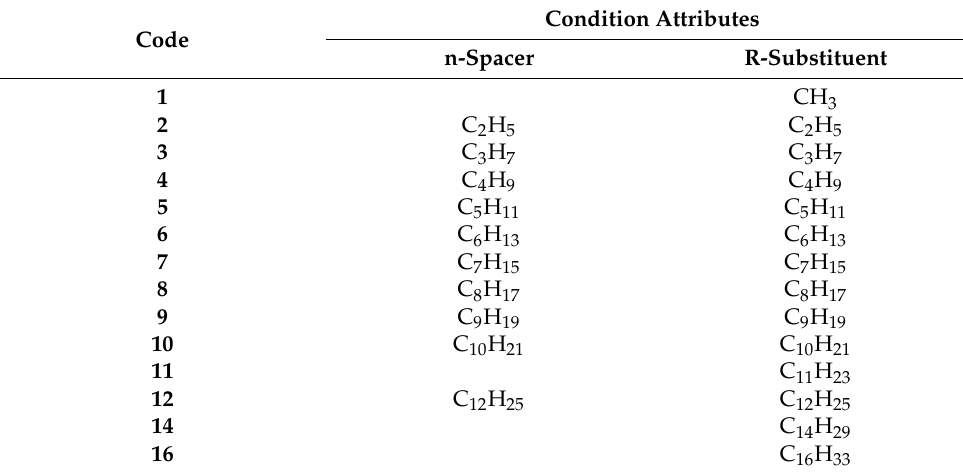
Table 4. Numerical coding of the structure of analyzed chlorides.